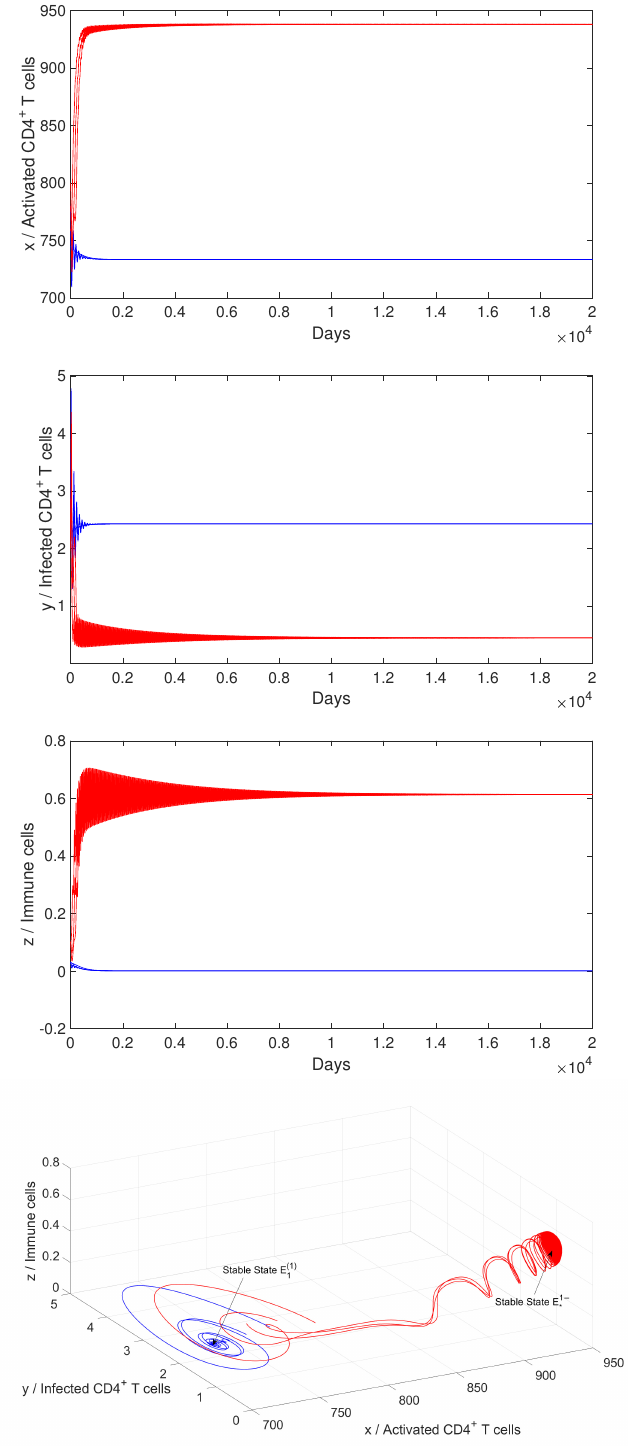
Figure 7. Time histories and trajectories of system (1) with different initial values for c = 0.37 day − 1 . ( 1 ) E and E 1 − ∗ are stable. System (1) shows the bistable phenomenon. Other parameter values are 1 listed in Table